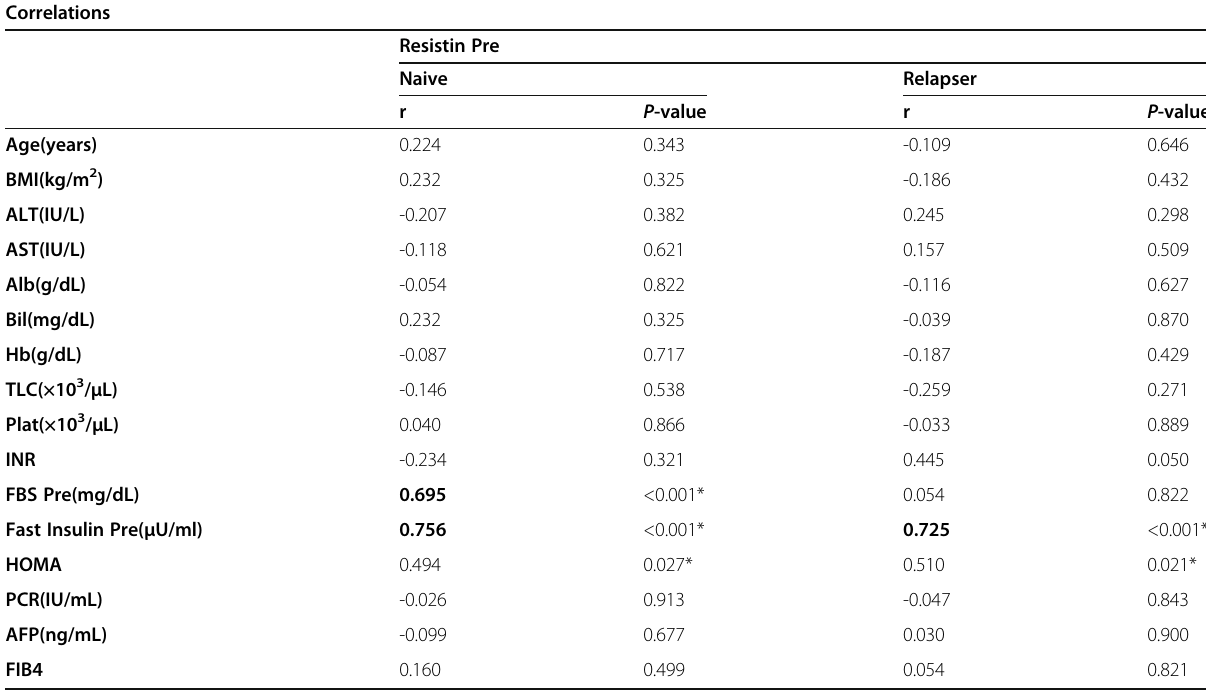
Table 6 Correlations between the Resistin Pre-treatment and all other parameters in the study in both groups of patients